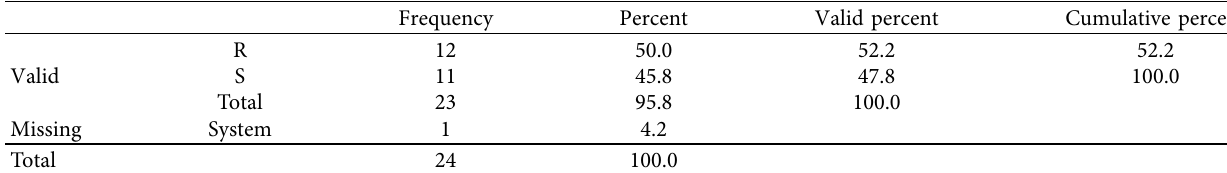
Table 9: Sample 20 antibiotic.